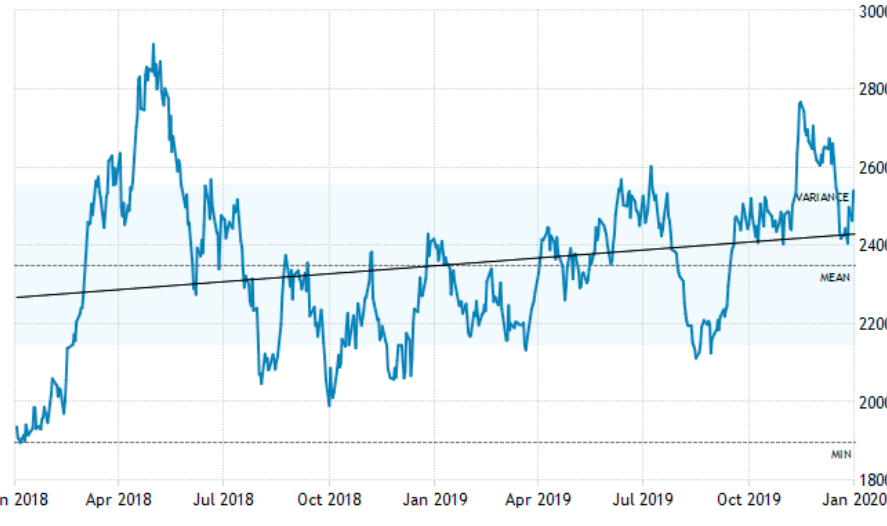
Figure 2. Monthly averages prices (USD/TM).